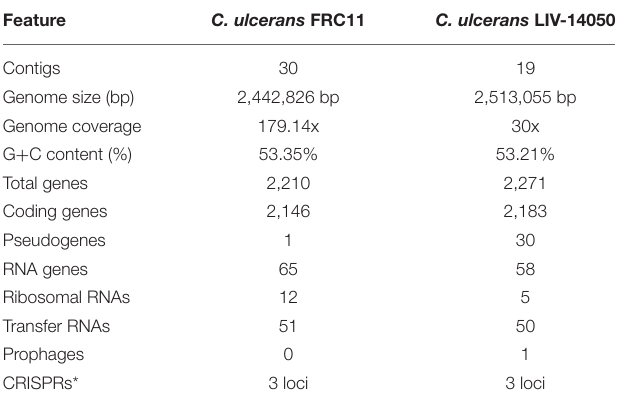
TABLE 2 | General features of the genome sequences of C. ulcerans FRC11 and C. ulcerans LIV-14050 isolated from a human and equine patients,